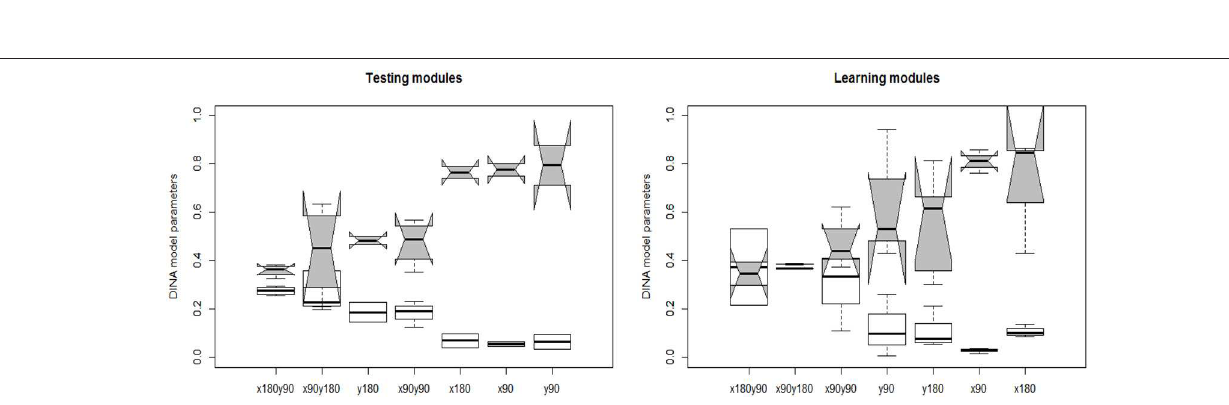
FIGURE 7 | The estimated DINA model item parameters. The white whisker diagram represents the slipping parameters s and the gray ones represent the guessing parameters g .